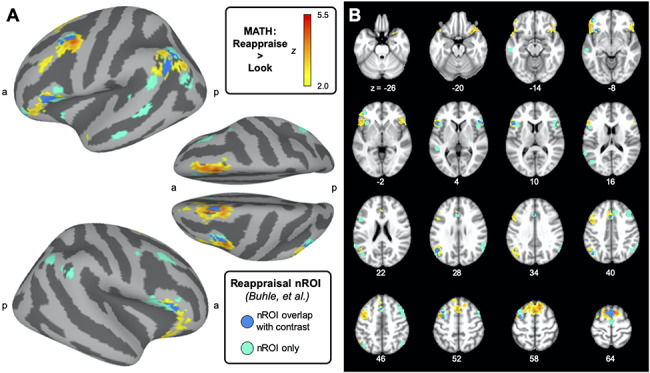
Correspondence between math reappraisal results and prior meta-analysis of reappraisal. Regions of brain activity activated by math reappraise trials vs math look trials, cluster corrected at P = 0.05, are depicted in yellow/orange. In turquoise, we show non-overlapping regions of activity highlighted by previous studies using cognitive reappraisal during ER studies using more traditional affective stimuli, compiled in a meta-analysis by Buhle et al. (2013). In darker blue, we observe the overlap between the functional contrast, and the areas highlighted by the Buhle et al. (2013) meta-analysis. In (A) these maps are depicted on the cortical surface, and in (B) we observe these same maps presented across a series of brain volumes. We observe a large degree of overlap between the math-related reappraisal activity and regions associated with reappraisal used in this meta-analysis where traditional affective stimuli were used. When we specifically compute activity within the reappraisal nROI (in turquoise), we find increased activity in these regions when we contrast activity in the math reappraise trials compared to the math look trials [t(73) = 3.19, P = 0.002].